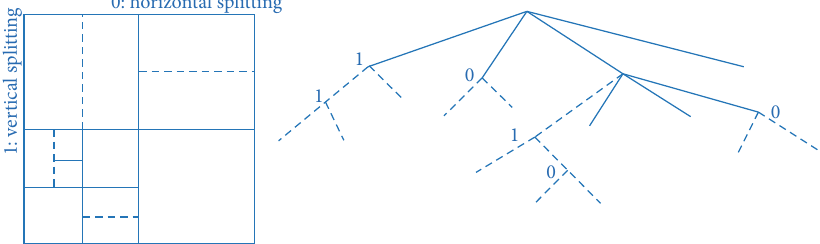
Figure 2: QTBT block partitioning structure.